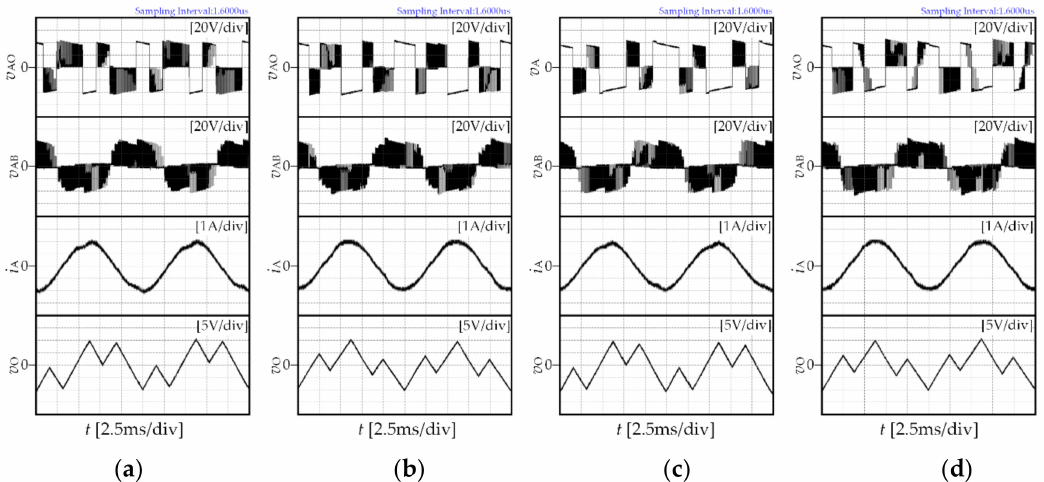
Figure 9. Experimental results of IDPWM0–IDPWM3 under two-phase load conditions when m ’ = 0.3: